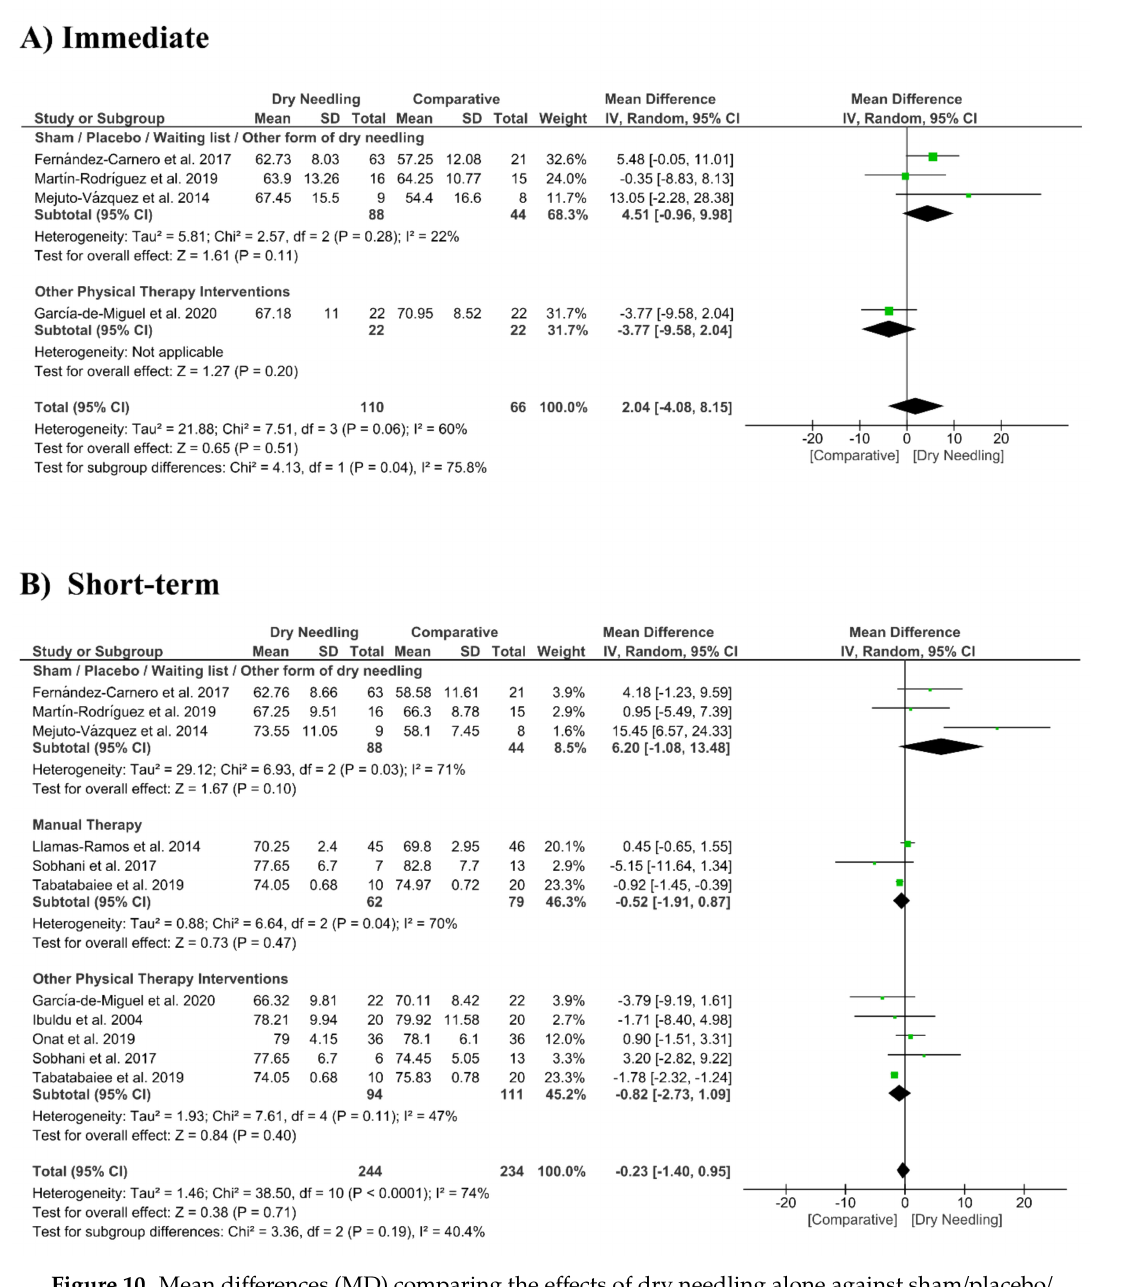
Figure 10. Mean di ff erences (MD) comparing the e ff ects of dry needling alone against sham / placebo / waiting list / other forms of dry needling or manual therapy or other physical therapy interventions on the cervical range of motion in rotation ( A ) immediately after and ( B ) at the short-term. SD: standard deviation; CI: confidence